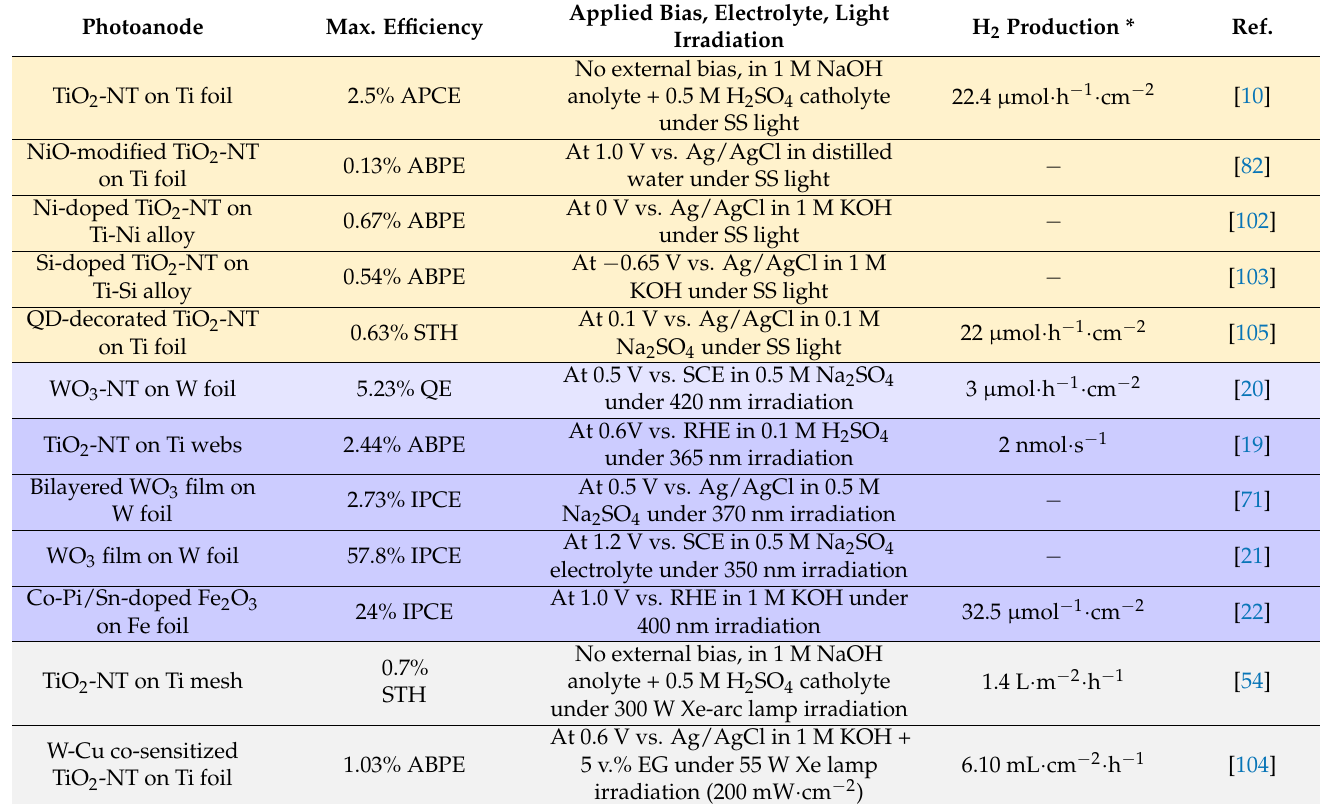
Table 3. Photoanodes of PEC water-splitting cells based on nanostructured anodic oxides, maximum efficiencies under experimental conditions described, and H 2 production. The references are classified according to the type of the irradiation source: solar simulated (SS) light (yellow background); monochromatic irradiation in visible region, 400 nm < λ < 700 nm (pale-violet background); and monochromatic irradiation in UV-A region, 320 nm < λ < 400 nm (violet background), other irradiation sources (gray background). Applied Bias, Electrolyte, Light Photoanode Max. Efficiency H 2 Production * Irradiation